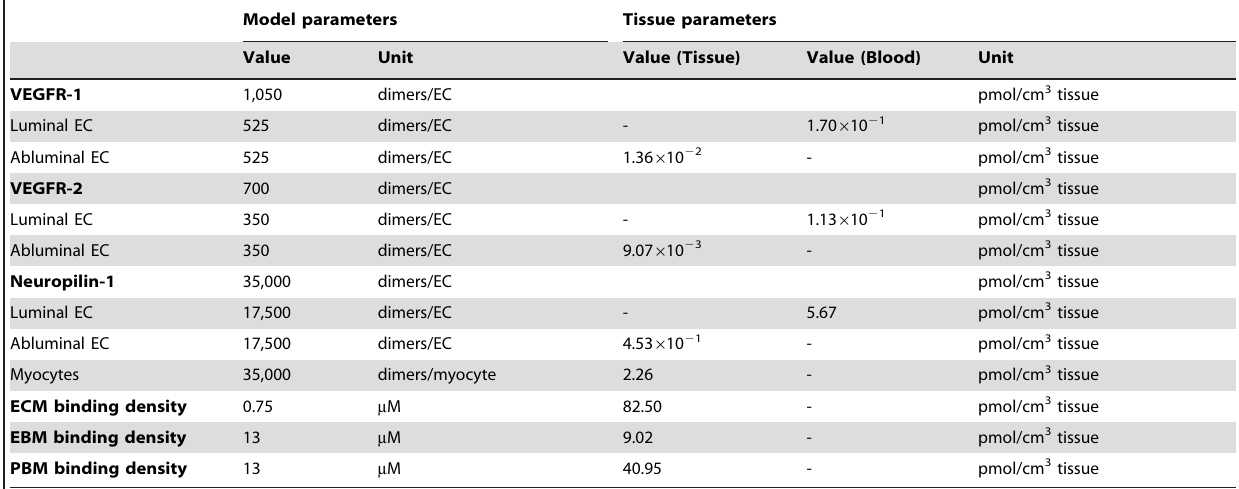
Table 3. Receptor densities.